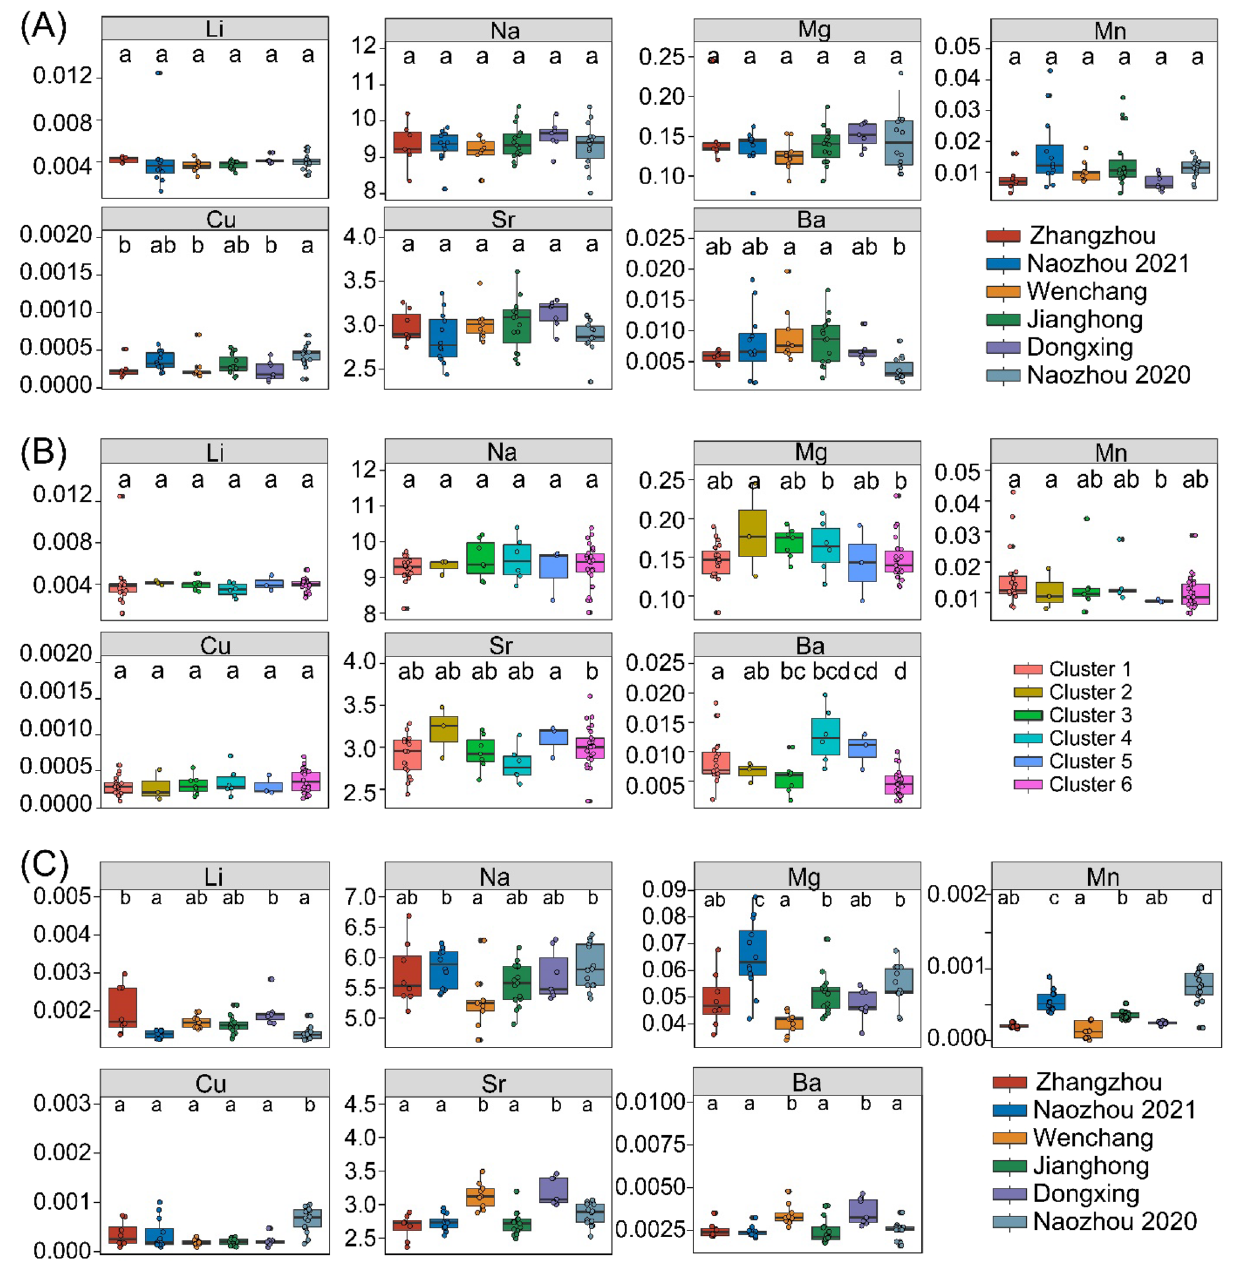
Figure 6. The mean element:Ca ratios of larval stage ( A ) comparisons of core data between different population, ( B ) comparisons between different clusters, and ( C ) comparisons of edge data between different populations. Different letters above the boxes indicate significant